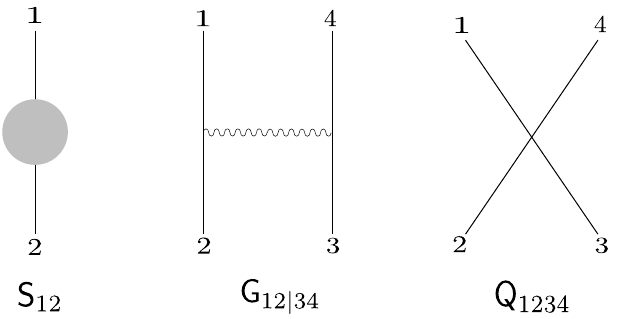
Figure 3 . Basic one-loop diagrams: the self-energy diagram S 12 , the gluon-exchange diagram G and the scalar quartic diagram Q 1234 12 j 34